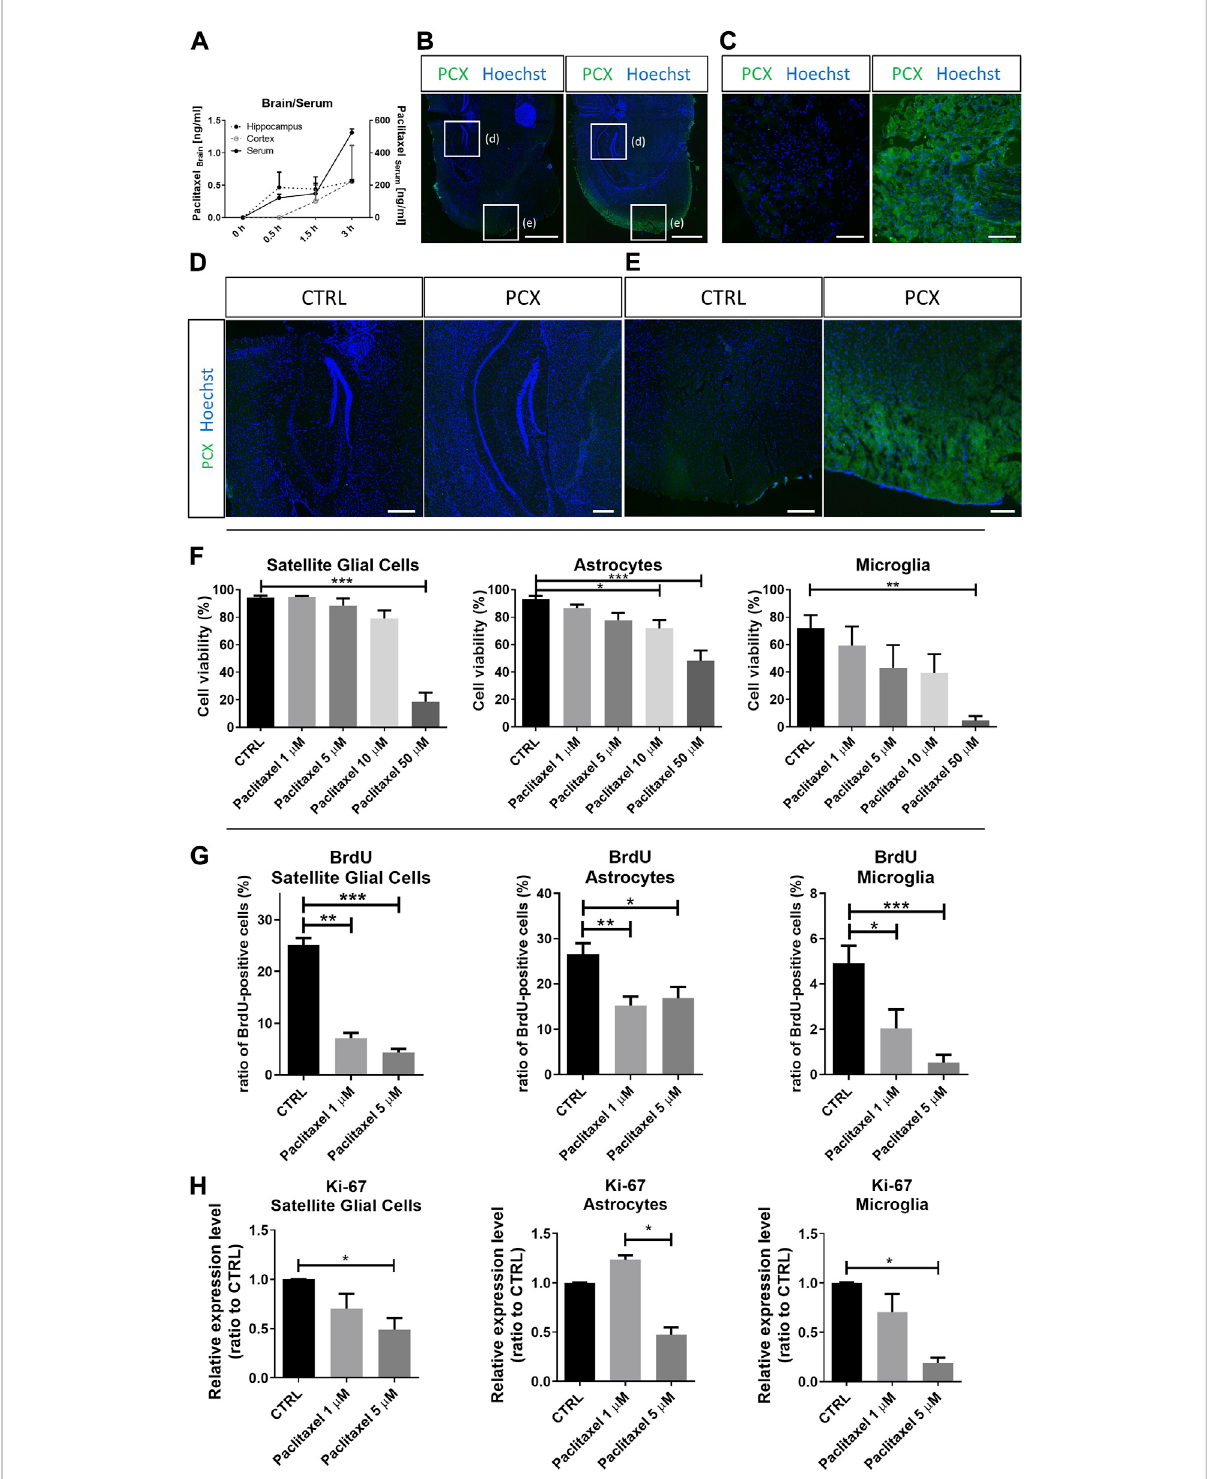
FIGURE 1 Efectofpaclitaxelonsurvivalandproliferationofglialcells. (A) 8-week-oldmicewereinjectedwith25 mg/kgpaclitaxel(PCX)andpaclitaxelamountsin serum( n (animals)=3),cortex( n (animals)=2),andhippocampus( n (animals)=2)wereassessed0.5 h,1.5 h,and3 hafterinjection.Thehighestamountsof paclitaxel were detected after 3 h. Graphs depict mean ± SEM. (B) Paclitaxel immunohistochemistry in the mouse brain after 3 h of injection and control- treated mouse. Scale bar = 500 μ m. (C) Paclitaxel immunohistochemistry in the mouse dorsal root ganglia (DRG) after 3 h of injection, compared to